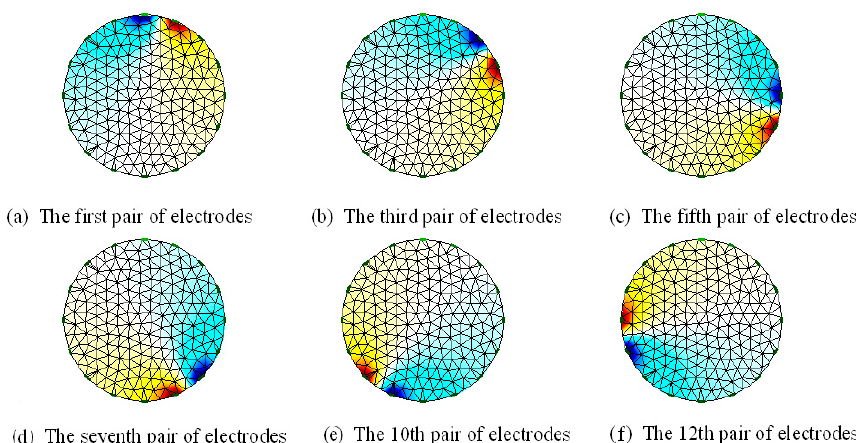
Figure 3. The voltage pattern from adjacent mode.